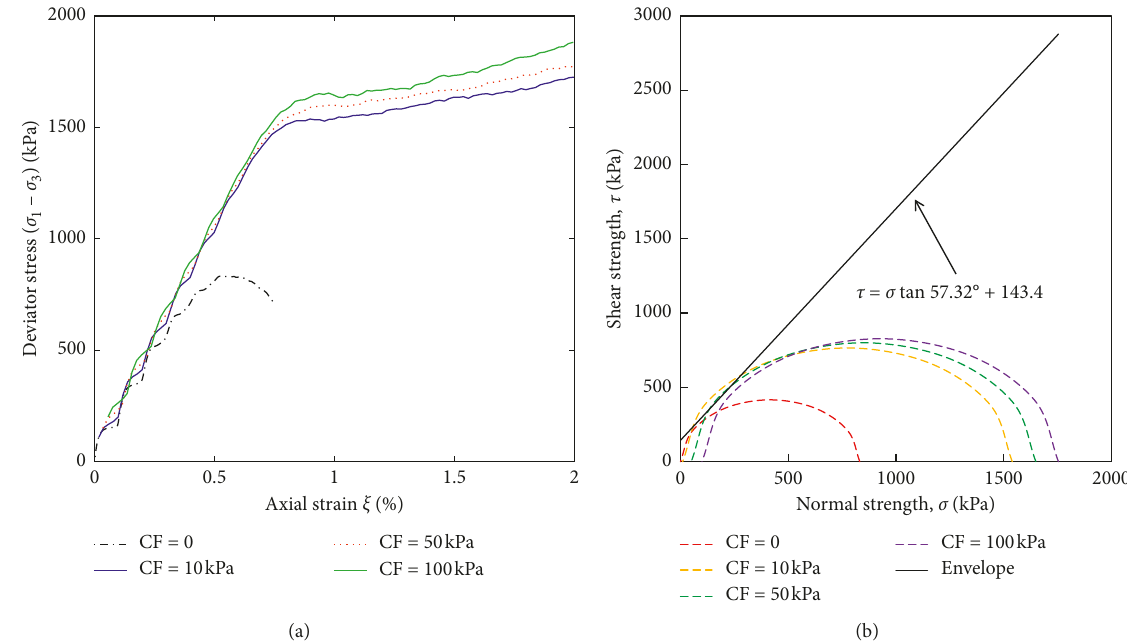
Figure 3: Triaxial tests of soil particles of (a) the triaxial test curves with confining pressures of 0, 10, 50, and 100kPa and (b) the triaxial test strength envelope and its fitting results.